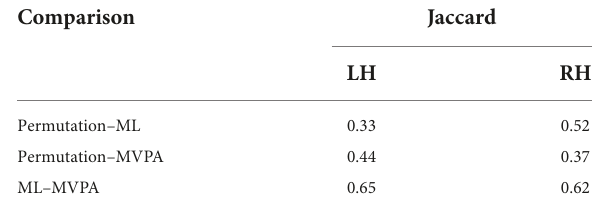
TABLE 4 Pairwise Jaccard comparison between the three